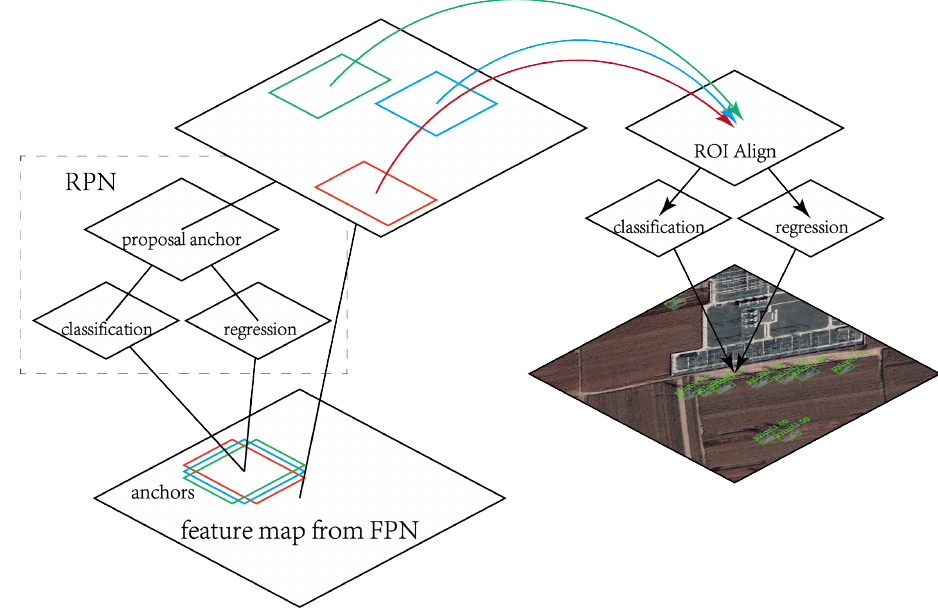
Figure 5. Structure of Faster R-CNN [19]. The input of Faster R-CNN is the output of FPN [43]. Tetragons with different colors represent different anchors. RPN (Region Proposal Network) is a fully convolutional network, classifying the anchors to foreground/background and regressing the bounding-box sketchily. ROI is the abbreviation of region of interesting and ROI Align layer [21] is used to reconcile the size of feature